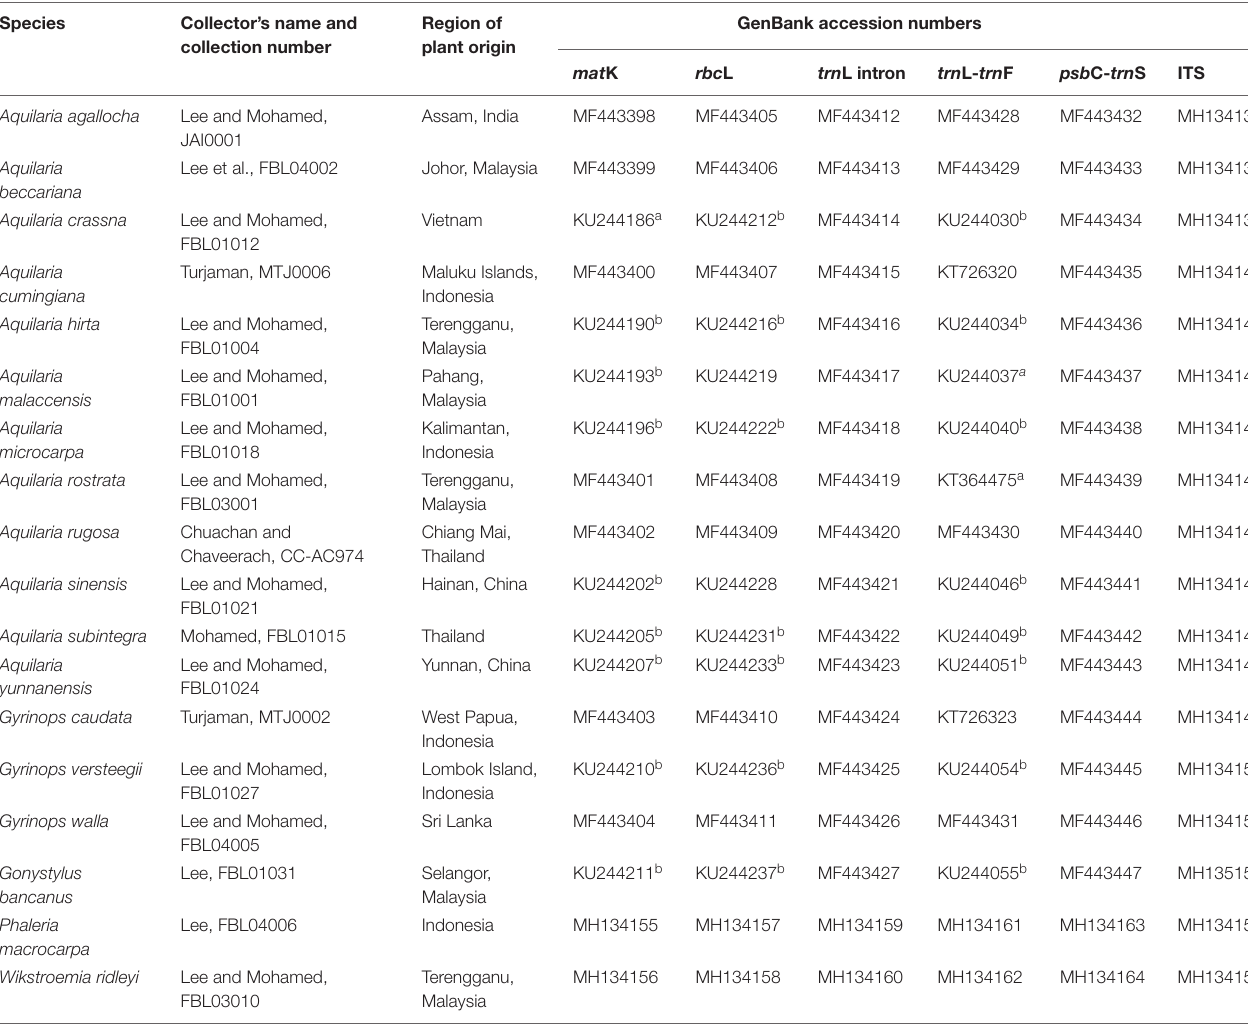
TABLE 3 | Localities, voucher details, and GenBank accession numbers of the selected species generated from this study, unless stated otherwise (refer to footnote).